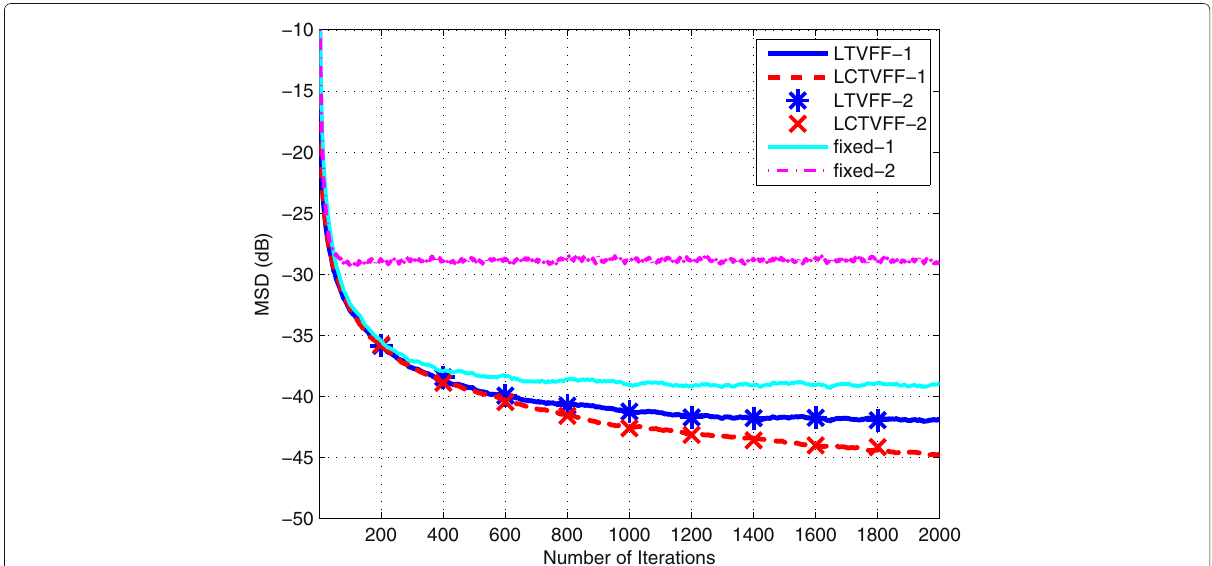
Fig. 8 MSD performance against iterations for the proposed algorithms with different initial values for the forgetting factor compared with the DRLS algorithm with the fixed forgetting factor